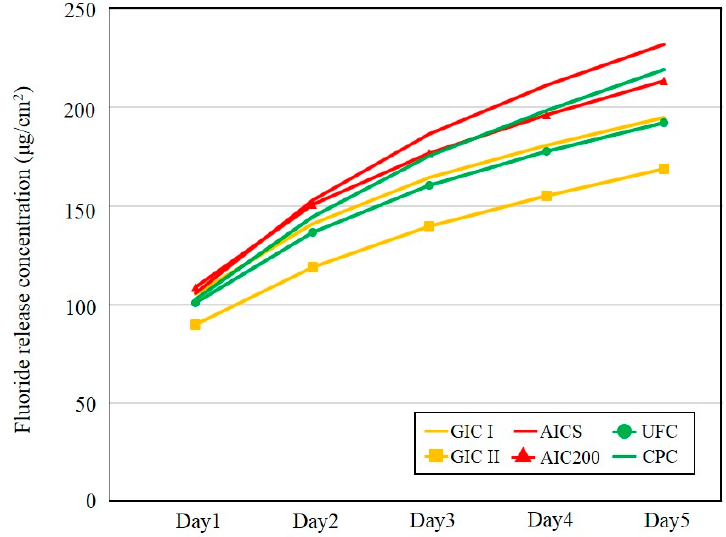
Figure 3. The accumulated amounts of fluoride ions released during Experiment II per unit sample surface area after five days ( n = 5/group).